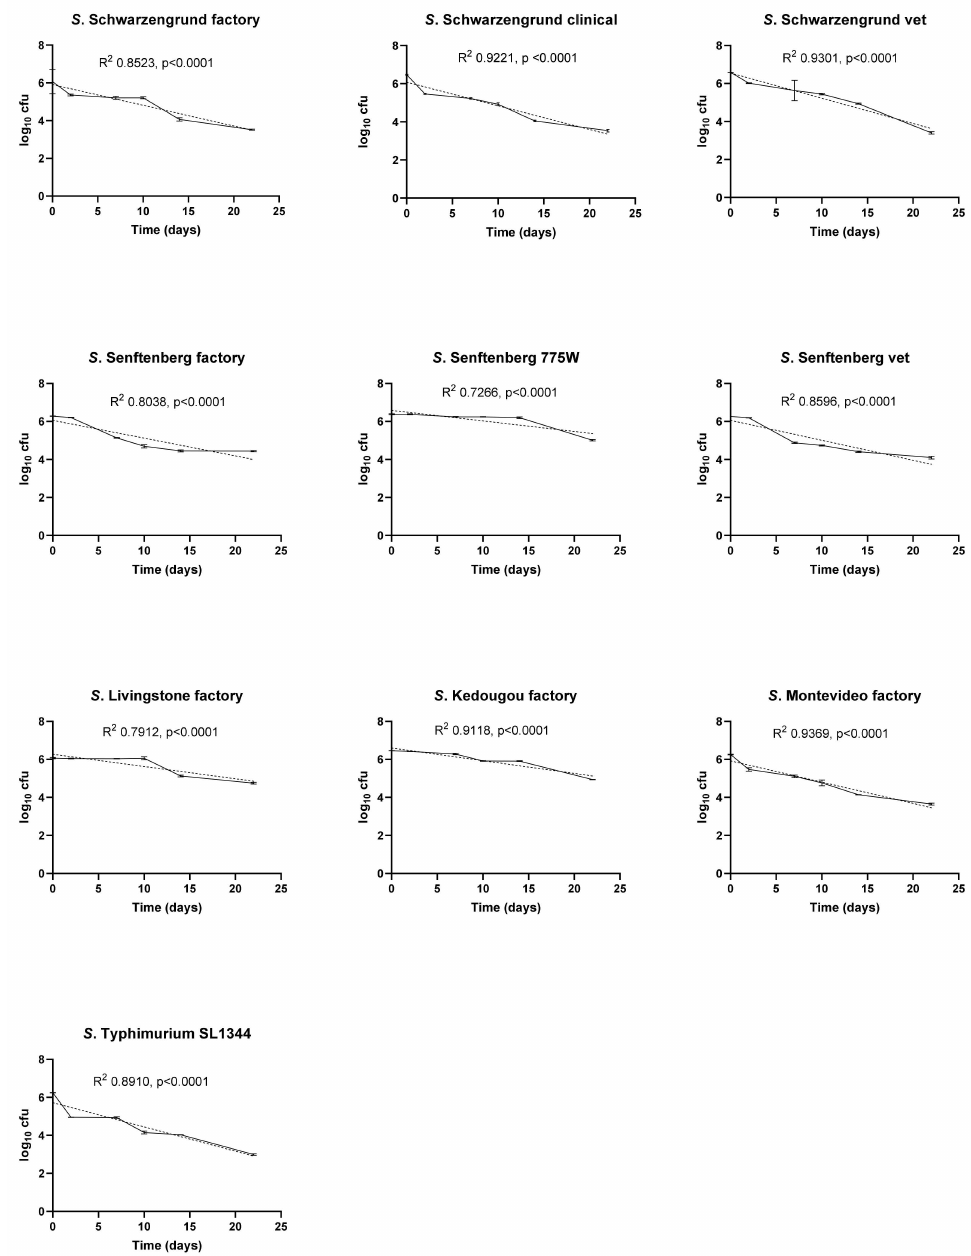
Figure 2. Survival of Salmonella isolates on stainless steel at 25 ◦ C, 15% RH. Viable counts are shown as log 10 cfu/coupon at each time point. Results are plotted as means of triplicate experiments with bars showing standard deviation. Best-fit lines determined by log-linear regression are included for each isolate with R 2 and p